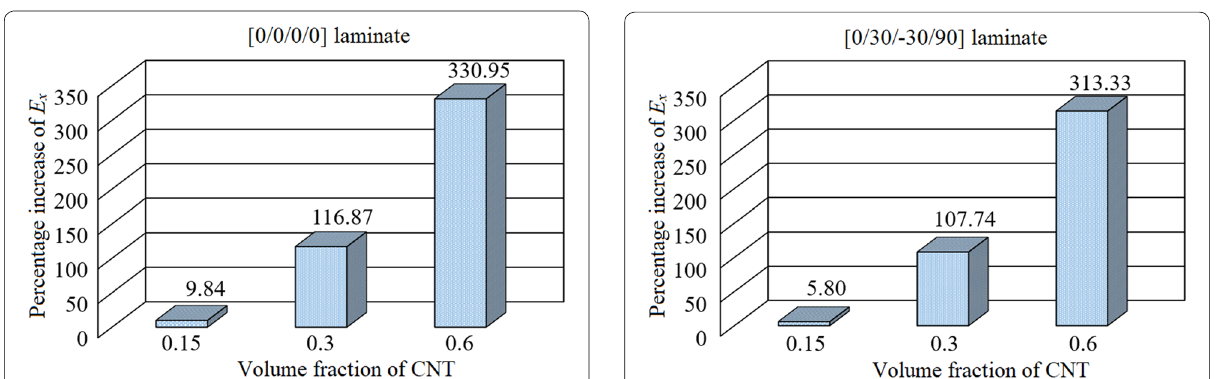
of E x as compared to the addition of 60% CF in epoxy. A maximum increase of 296.43% has been observed for CNT/epoxy as compared to CF/epoxy for the same fibre volume fraction of 60% for [0/90/0/90] laminate con- figuration. But for [0/30/–30/90] laminate configuration the maximum increase of 313.33% has been observed for CNT/epoxy composite as compared to CF/epoxy composite with the same fiber volume fraction of 60%. Therefore, it could be concluded that a similar trend of percentage increase in E x with CNT volume fraction has been observed from Figs. 5, 6, 7 for all the stacking sequences of composite laminates. The strength of the laminated composites depends on the stacking sequence of different laminae in the laminate, therefore, for a par- ticular volume fraction, the values of the percentage increase in E x are different.